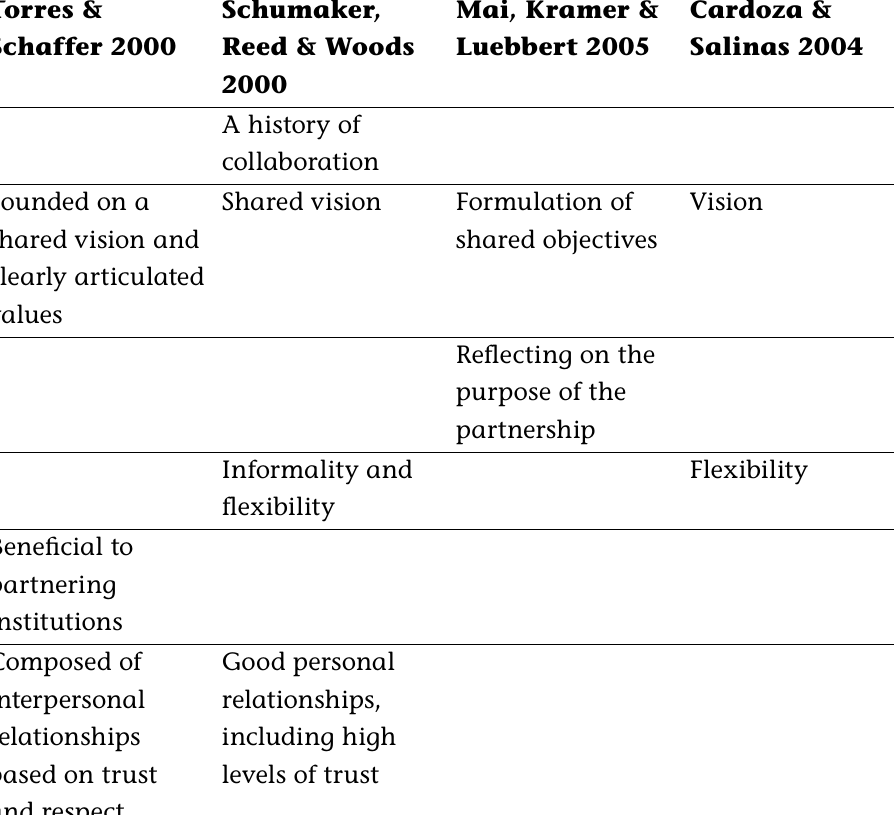
Table 1: Comparison of four lists of characteristics for successful university- community